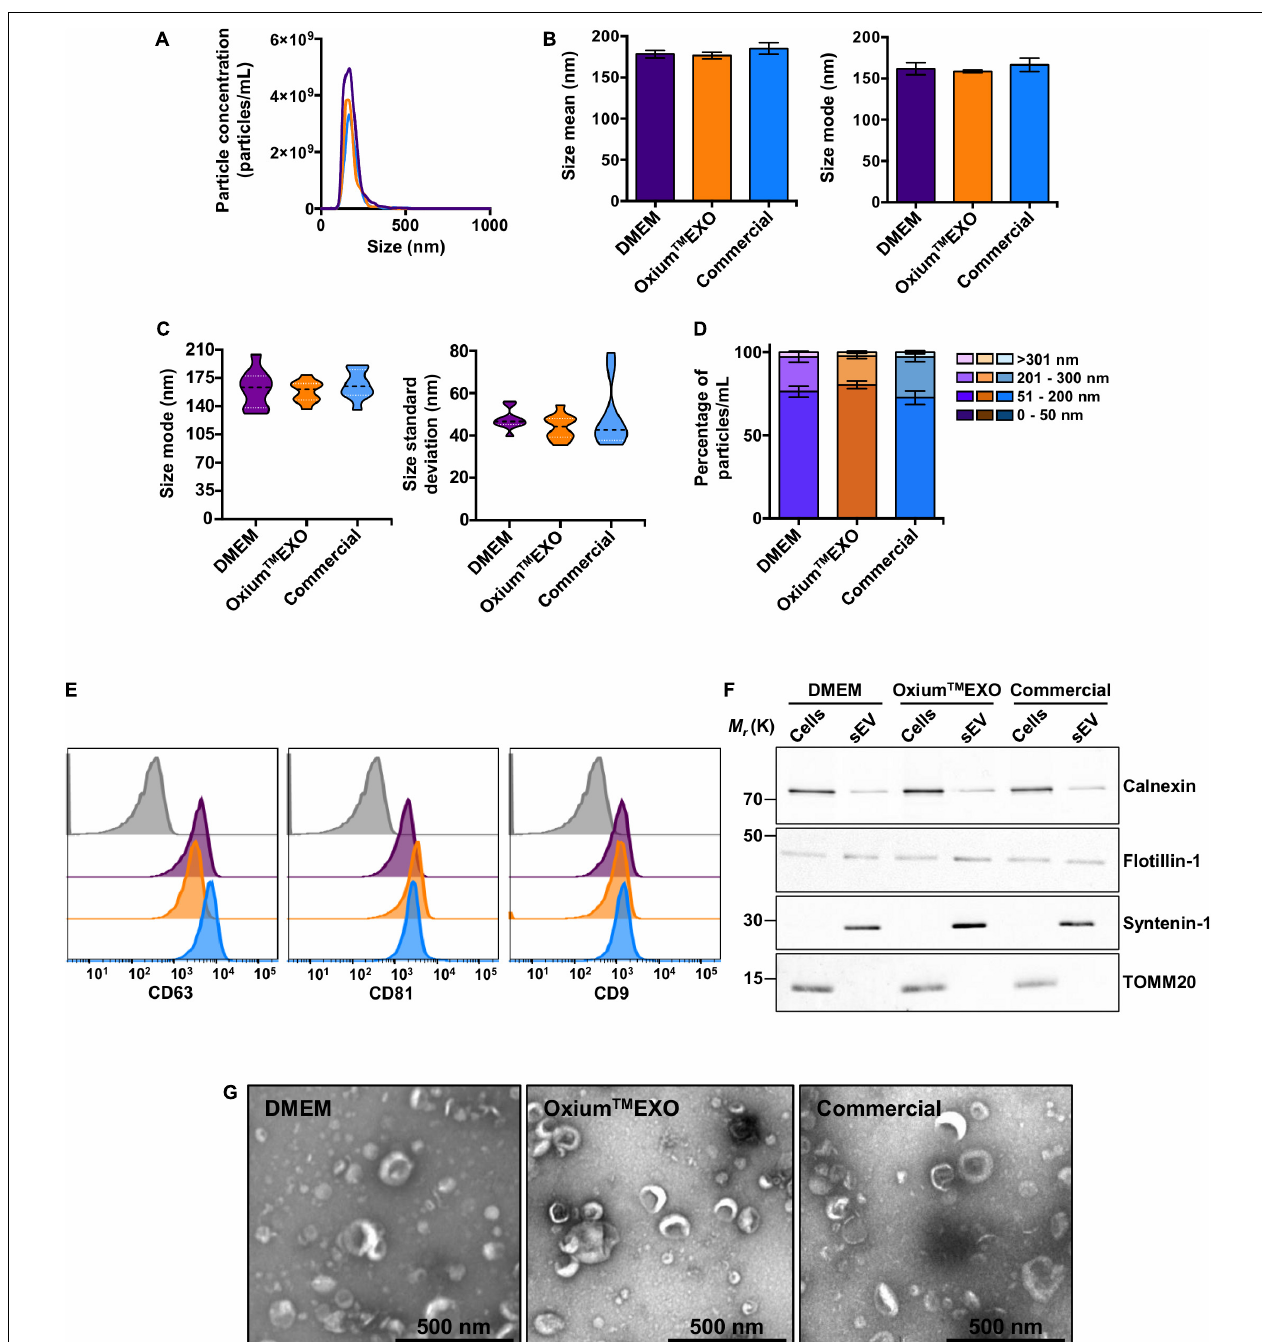
FIGURE 3 | Characterization of isolated UC-MSC-derived sEV produced in DMEM, Oxium TM EXO, and commercial medium. The sEV isolated from the different conditioned media were evaluated in terms of particle concentration, size, classical surface/interior markers, and morphology. (A) Histogram showing the particles’ concentrations according to their size. Violet line = DMEM-derived sEV; orange line = Oxium TM EXO-derived sEV; light blue line = commercial medium-derived sEV. The mean concentration obtained through NTA of five videos for each type of sEV is shown. (B) Size’s mean and mode obtained for each type of sEV. (C) Size’s mode (left panel) and standard deviation data (right panel) dispersion. (D) Percentage distribution of isolated particles’ concentrations according to their size: 0–50 nm, 51–200 nm, 201–300 nm, and > 301 nm. (E) Representative histograms of median fluorescence intensity (MFI) obtained by flow cytometry of classical sEV surface markers. Gray = isotype control; violet = DMEM; orange = Oxium TM EXO, light blue = commercial medium. (F) Western blot, illustrating the presence of the sEV’s membrane-associated protein Flotillin-1 and the sEV’s luminal-scaffold protein Syntenin-1 (involved in sEV’s biogenesis). Note that in the isolated sEV there is minimal or no detectable contamination by Calnexin (endoplasmic reticulum) or TOMM20 (mitochondria), respectively. (G) Transmission electron microscopy (TEM) by uranyl acetate negative staining of isolated sEV from ultracentrifuge. The graphs show mean ± SEM. n = 2.